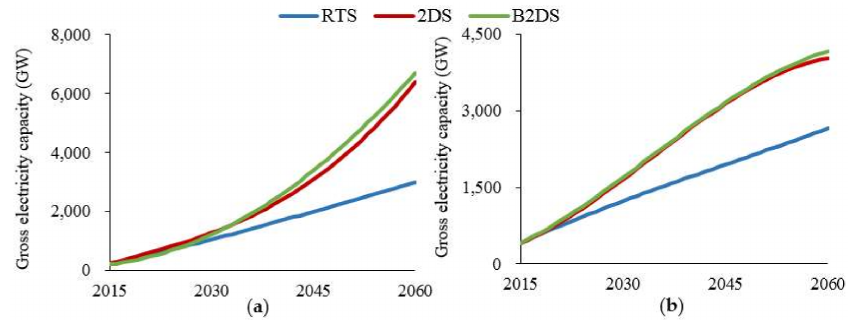
Figure 1. Cumulative electricity capacity in each scenario. ( a ) Solar power ( b ) Wind power (after International Energy Agency (IEA) [4]).